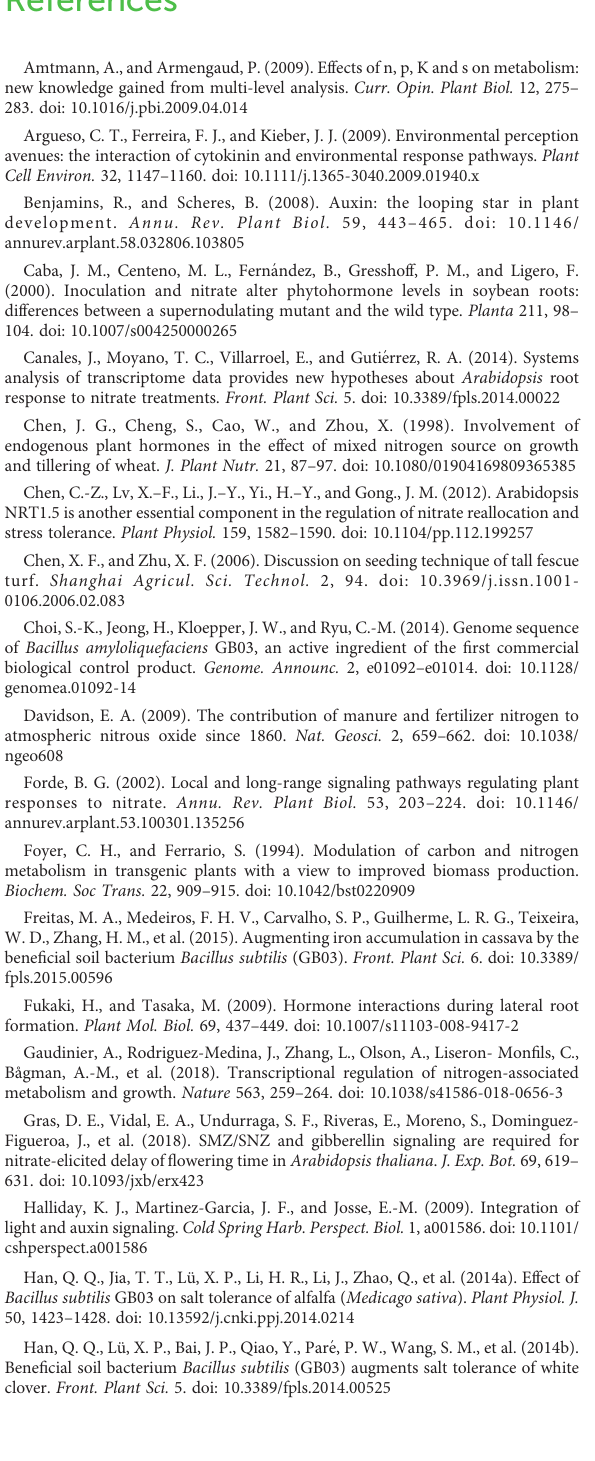
SUPPLEMENTARY TABLE 1 Effects of DH5 a and GB03 on tall fescue growth under various concentrations of NO 3- . The treatments were: total nitrogen (TN),